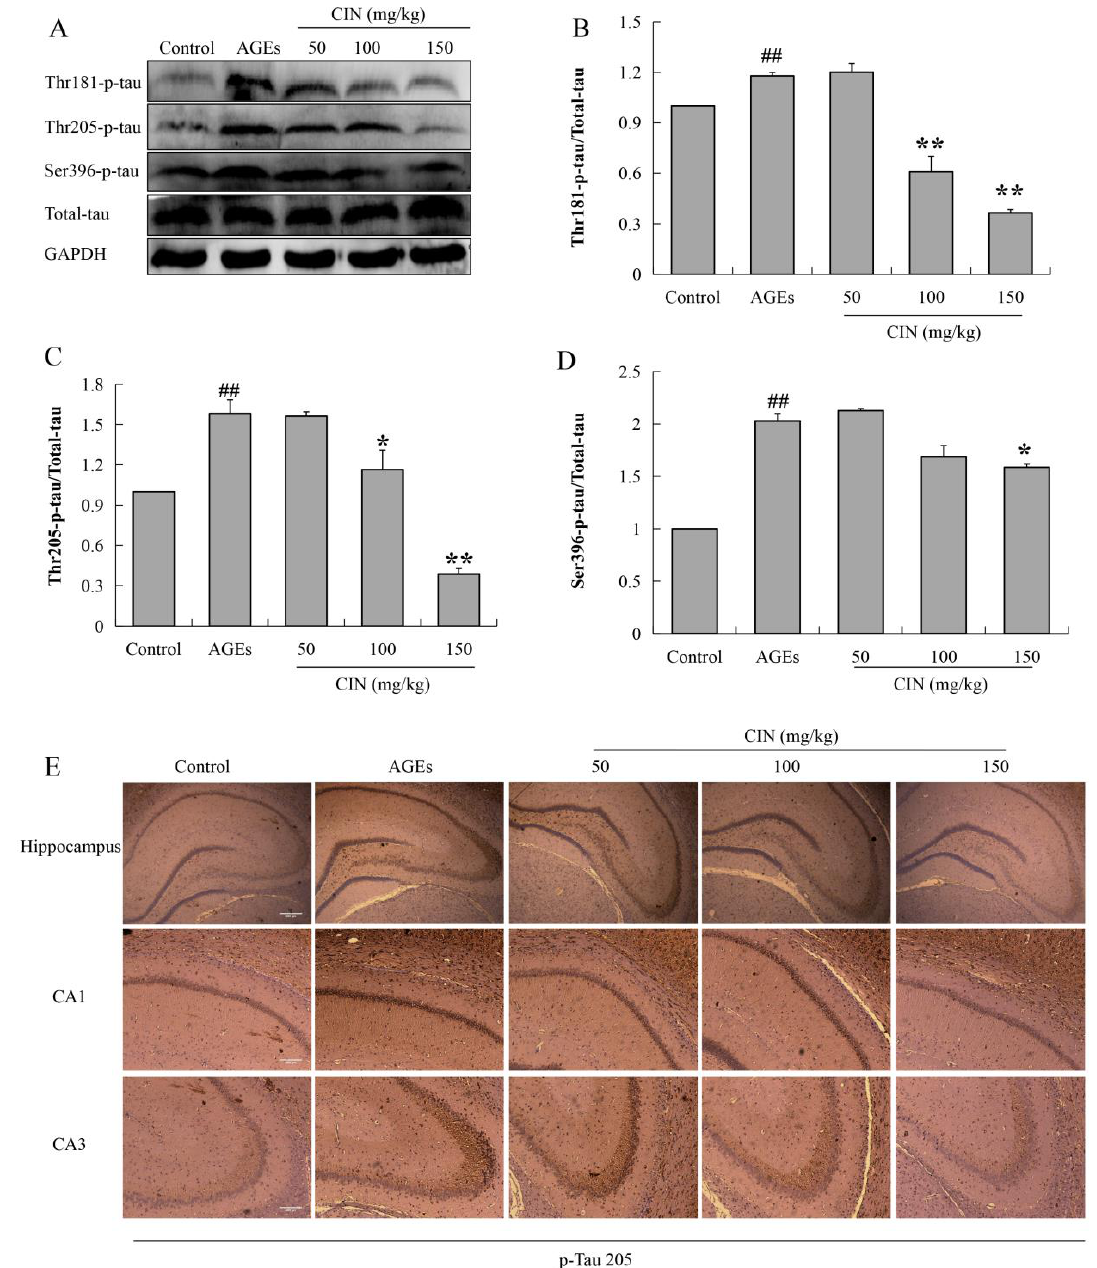
Figure 4. Effects of CIN on the tau hyperphosphorylation in vivo. ( A – D ) The protein levels of phosphorylated tau at thr181, thr205 and Ser396 sites in rat hippocampus were detected by Western blot. n = 8. ( E ) IHC staining of rat brain immunostained with antibody against thr205-phosphorylated tau (scale bar, hippocampus group: 500 µ m; CA1, CA3 group: 250 µ m). ## p < 0.01 compared with the control group; * p < 0.05, ** p < 0.01 compared with the model group.